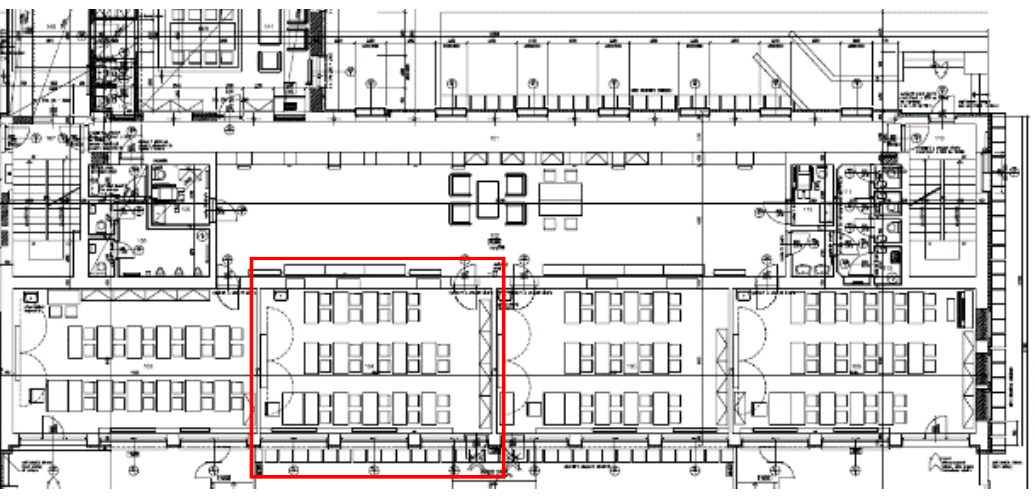
Figure 1. Situational layout of the school campus location.